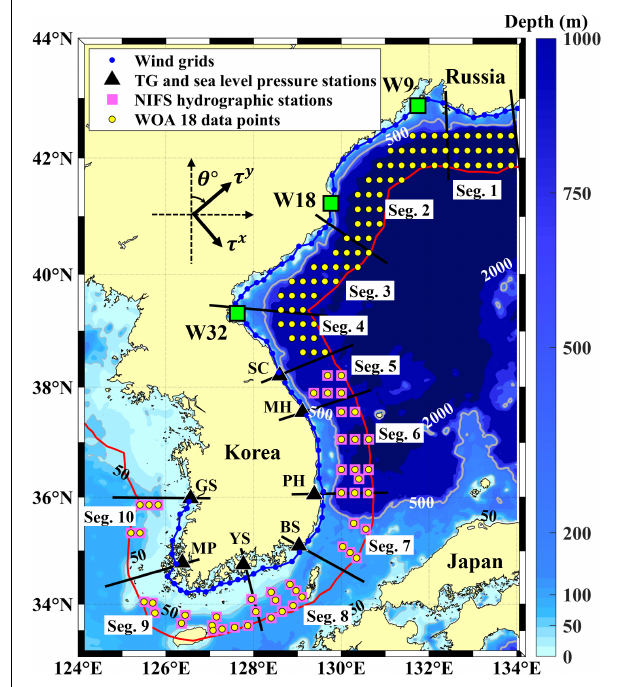
FIGURE 1 | Bottom topography around the Korean Peninsula (KP). Water depth is shown with colors and contours, where 50 and 500 m isobaths are highlighted by thin and thick lines, respectively. Coastal zones (between coastline denoted with blue line and offshore boundary 100 km distant from the coastline denoted with red line) off the north coast (Segs. 1–4), east coast (Segs. 5–7), south coast (Segs. 8–9), and west coast (Seg. 10) of the KP are divided into 10 segments (Segs. 1–10; labeled) as marked by thick black lines. The grid points for wind stress data (wind grids) are denoted by blue circles along the coast. Locations of the tide-gauge (TG) sea level stations along the coasts around the KP, three wind grids (W9, W18, and W32), stations for the South Korea National Institute of Fisheries Science (NIFS) hydrographic observation, and World Ocean Atlas 2018 (WOA18) data grids are denoted with black triangles, green squares, pink squares, and yellow circles, respectively. The coordinate system for sea surface wind stresses ( τ x , τ y ) and currents, with a rotation angle, θ , measured clockwise from the north, are marked with thick arrows.